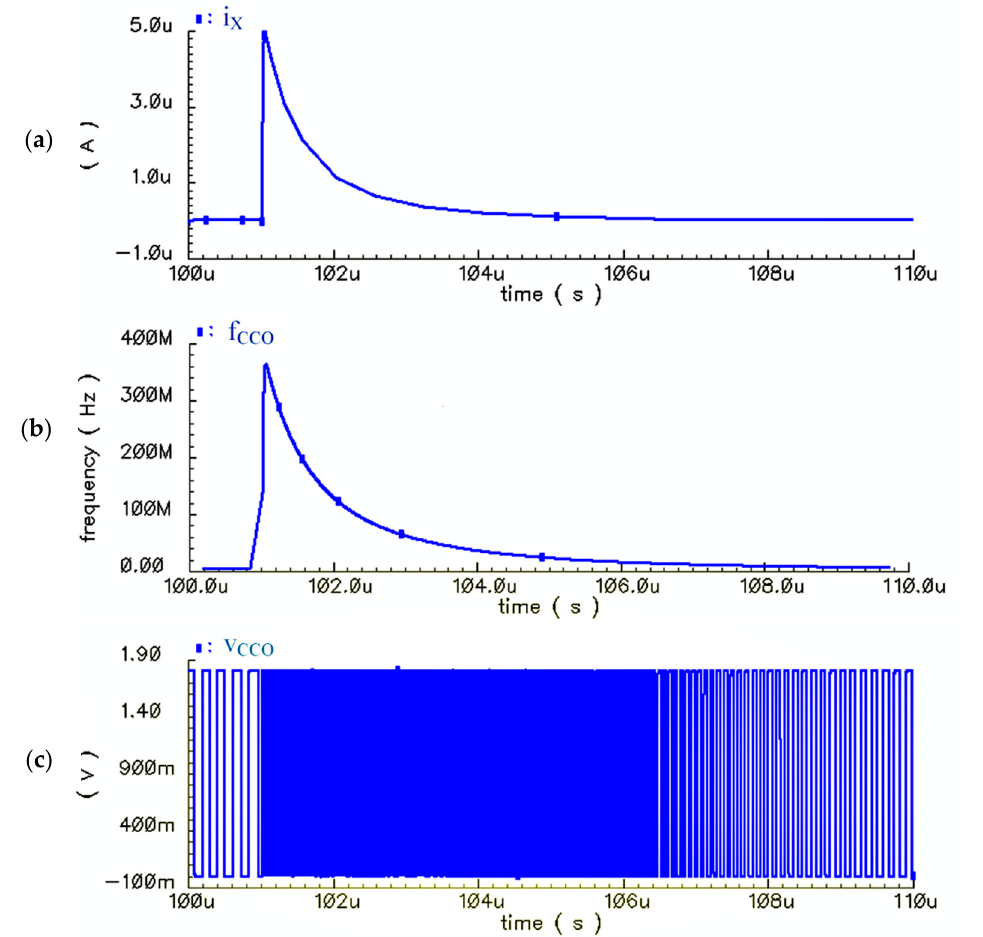
Figure 16. ( a ) Variations of the CBCM output current ( i X ) versus time, ( b ) Variations of the output frequency of the CCO ( f CCO ) versus time, ( c ) Variations of the CCO output voltage pulses ( v CCO ) for the CBCM output current as the CCO input ( i CCO = i X ) for Δ C = 60 fF (in order to show the compact high frequency pulses more clearly and to lower their frequencies, I bias is omitted from the input of the CCO).